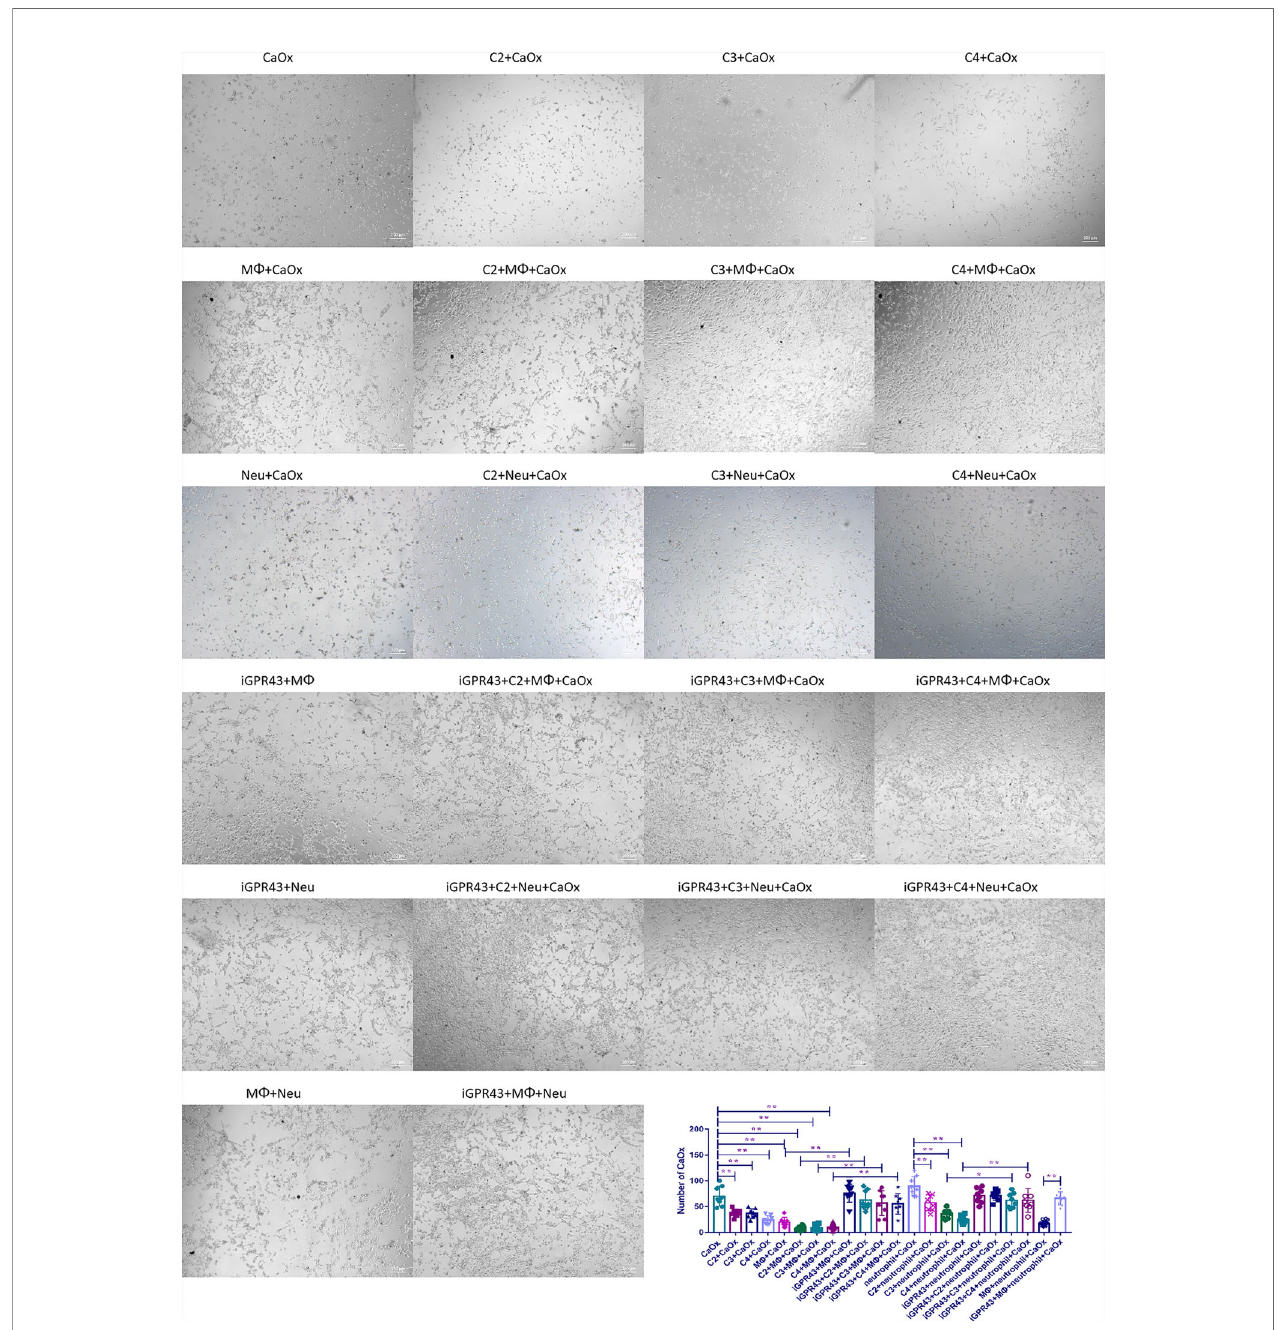
FIGURE 13 | Adhesion of CaOx crystals on mouse renal tubular epithelial cells (TCMK-1 cells) when treated with SCFAs, macrophages, neutrophils and GPR43 antagonist. Statistically signi fi cant was shown as *p < 0.05, **p <